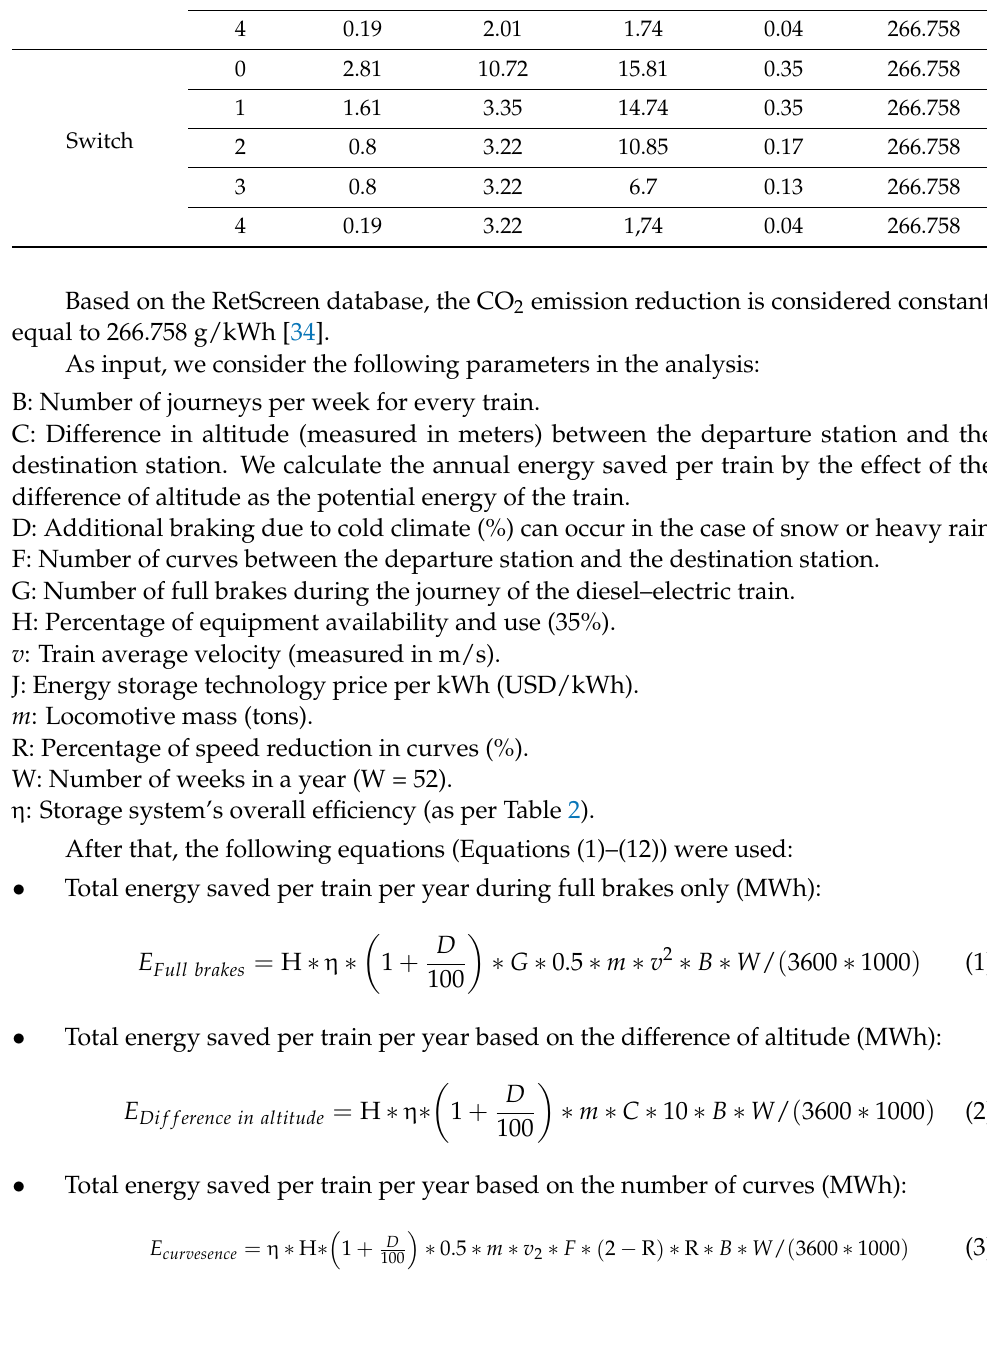
GHG emission ratio: Table 3 below shows the GHG emissions coefficients according to the duty cycle and tier [33]. The “switch” type duty cycle is used at tier 3 for all the GHG emissions in this study. Table 3. GHG emission standard coefficients (g/kWh) [33]. Duty Cycle Tier HC CO NO x PM CO 2 0 1.34 Line-haul